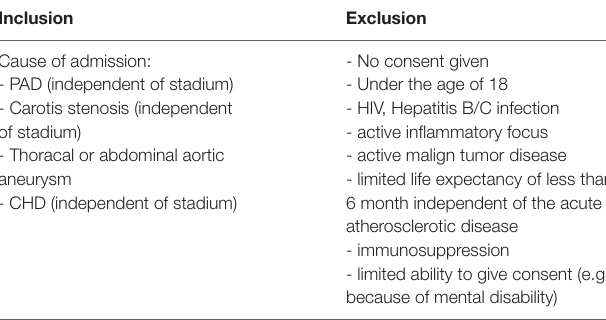
TABLE 1 | Inclusion and exclusion criteria of patients participating in this